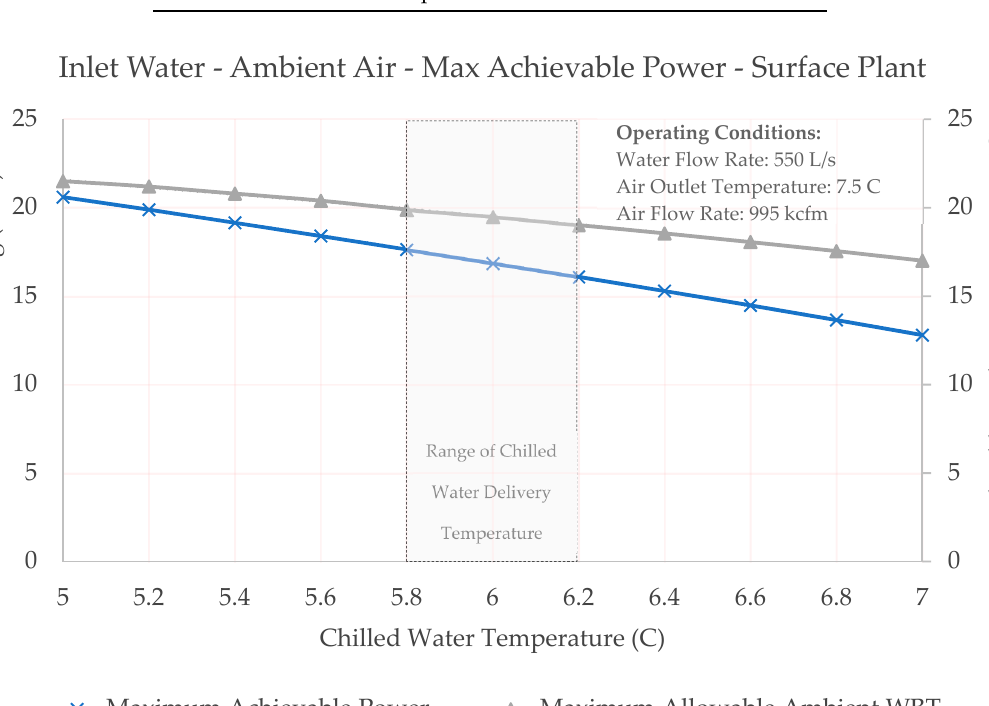
Figure 9. Surface plant design and operating ranges showing maximum attainable cooling power at different surface ambient temperatures.